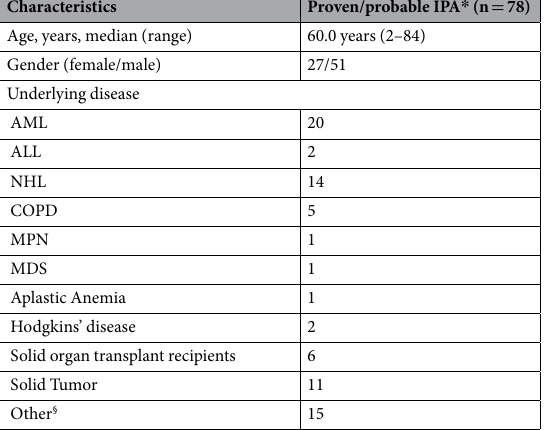
Table 1. Patient characteristics of proven/probable IPA cases. * according to 2008 EORTC/MSG criteria for non-ICU and BLOT criteria for ICU patients IPA: invasive pulmonary aspergillosis; AML: acute myeloid leukemia; ALL: acute lymphoblastic leukemia; NHL: Non-Hodgkin’s-Lymphoma; COPD: chronic obstructive pulmonary disease; MDS: myelodysplastic syndrome; MPN: myeloproliferative neoplasia; §Consisting of polymyalgia rheumatica, goodpasture syndrome; HIV infection with low CD4-cell count < 250/ µ l, granulomatous polyangiitis, rheumatoid arthritis, Crohn’s disease, vasculitis, liver